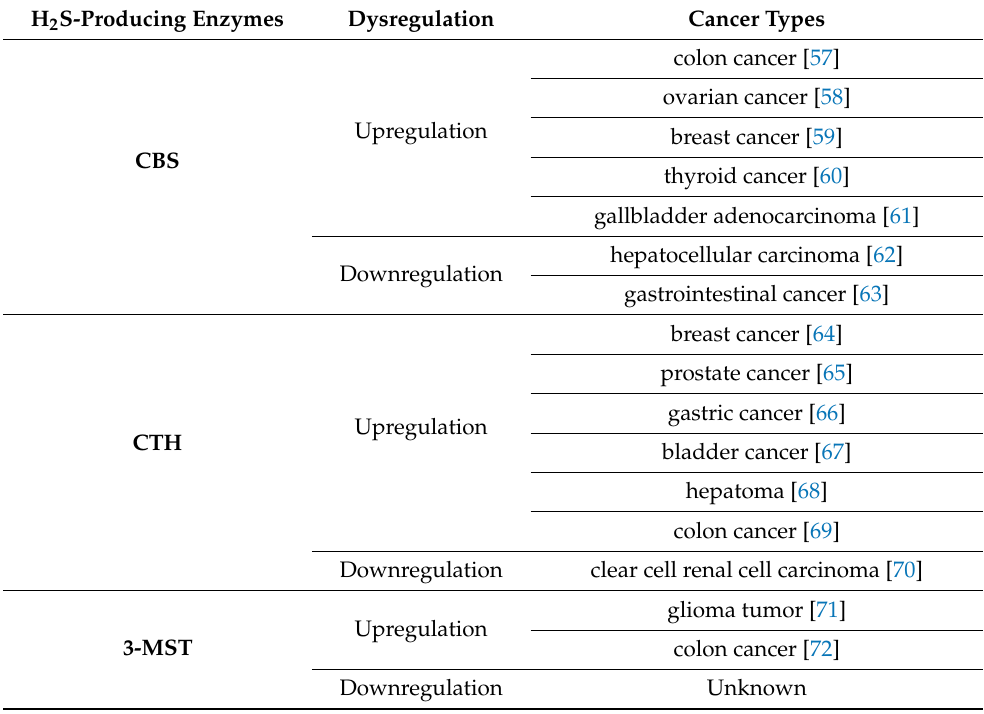
Figure 2. Simplified illustration of endogenous H 2 S production pathways. Three principal enzymes responsible for H 2 S production are CBS, CTH, and 3-MST. Homocysteine is the major substrate for H 2 S production. CTH and CBS generate H 2 S majorly in the cytosol, while 3-MST generate H 2 S in mitochondria. CBS, cystathionine β -synthase; CTH, cystathionine γ -lyase, 3-MST, 3-mercaptopyruvate sulfurtransferase; CAT, cysteine aminotransferase. Table 1. Overview of upregulation and downregulation of three H 2 S producing enzymes in different cancer types.